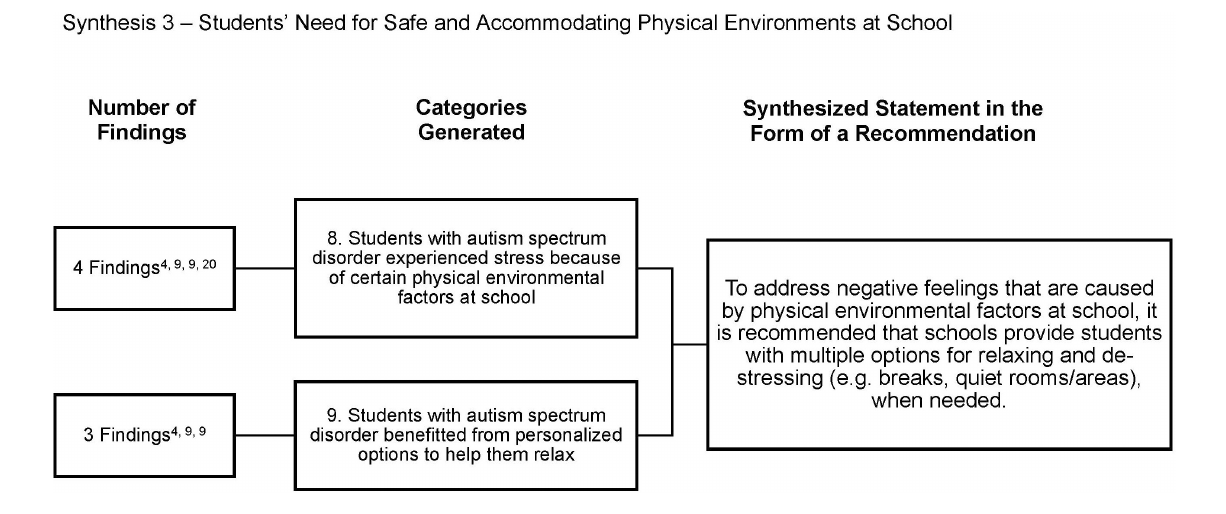
FIGURE 4 | Synthesis 3 – students’ need for safe and accommodating physical environments at school. The superscript numbers under “Number of Findings” corresponds to the study numbers in Table 3